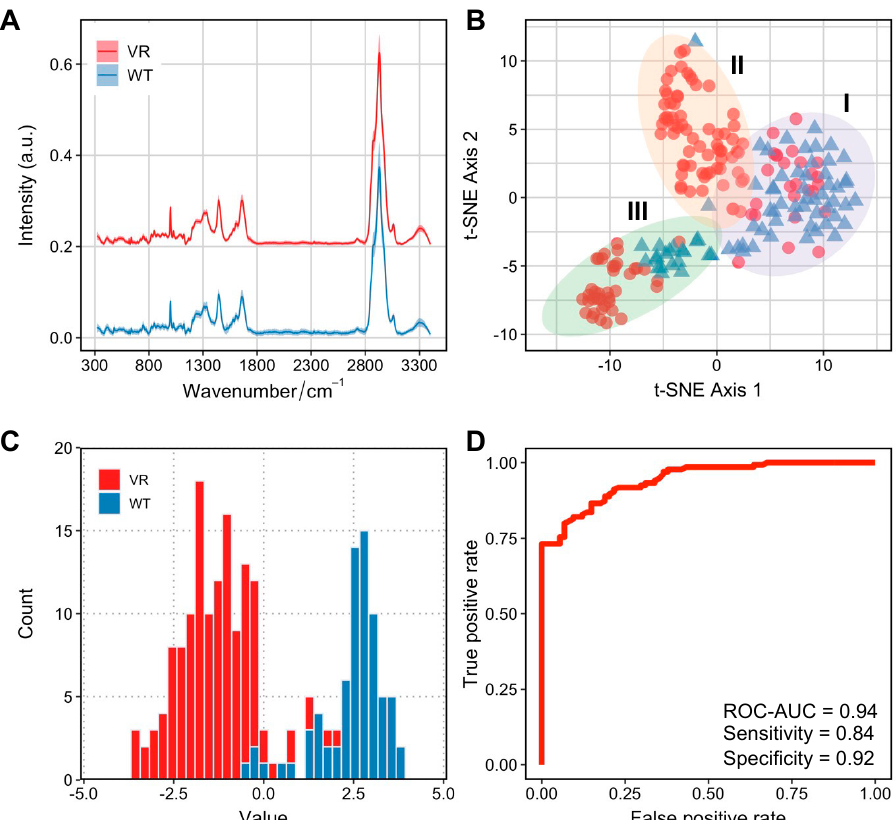
Figure 3. Distinct Raman profiles of Caco-2 and VR Caco-2 cells. ( A ) Raman spectra of VR Caco-2 and Caco-2 cells averaged from 218 and 92 single cells, respectively. The shaded area represents standard deviation at each wavenumber from single-cell measurements. Raman spectra from each group was shifted and scaled in intensity to aid visualisation and the intensity is expressed in arbitrary unit (a.u.). ( B ) Unsupervised tSNE visualisation observes three distinct clusters I, II and III comprised of heterogeneous Caco-2 and VR Caco-2 single cells. ( C ) Histogram of values of a linear discriminant analysis (LDA) model to differentiate Caco-2 and VR Caco-2 based on their Raman spectra. ( D ) A receiver operating characteristic (ROC) curve was used to evaluate the LDA model performance. The area under the ROC curve (ROC-AUC) was 0.94 where 1 indicates perfect classification.